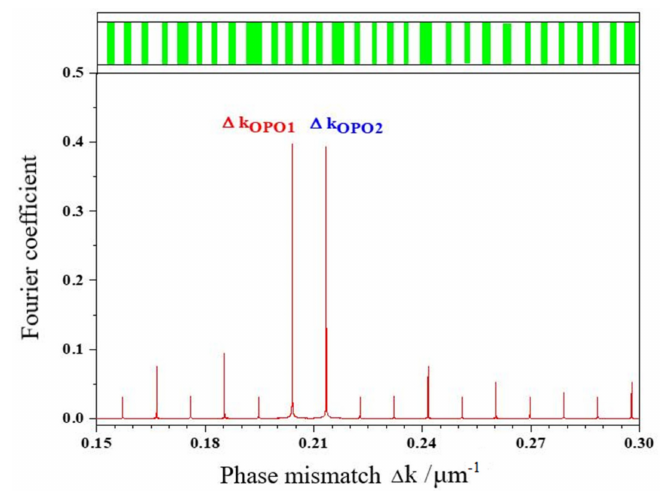
Figure 2. Polarization structure and phase mismatch of MgO:APLN.